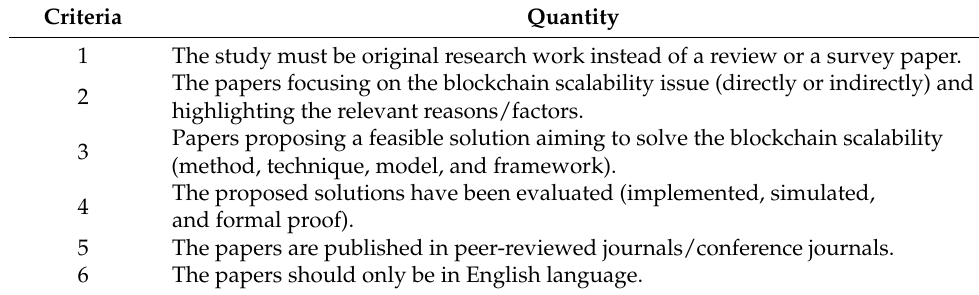
Table 3. Inclusion and exclusion criteria for this